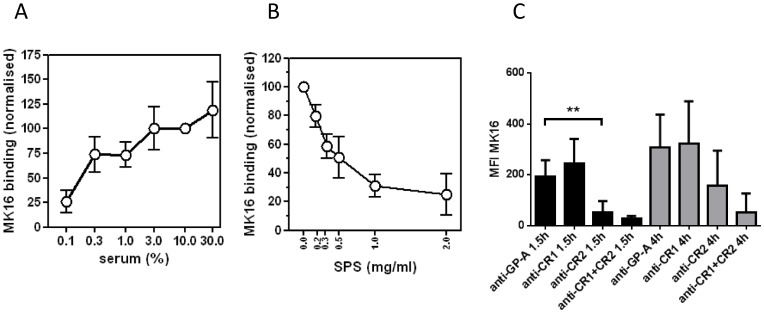
Influence of complement on the presentation of MBP85-99 by DR15+ B cells.PBMCs from healthy HLA-DR15+ donors were incubated for 18 h with MBP in media containing normal serum. Cells were stained with FITC anti-CD19 and biotinylated MK16, followed by streptavidin-PE. (A) The binding of MK16 at different serum concentrations is shown as mean fluorescence (MFI) values normalised to that of 10% serum, (N = 4). B) Before addition of serum (30% v/v), different concentrations of the complement inhibitory compound sodium polyanethole sulphonate (SPS) were added. MFI values are shown, normalised to samples without SPS, (N = 6). (C) The PBMCs were pre-incubated with the anti-CR1 mAb3D9 or polyclonal sheep anti-human CR2, or both, before addition of serum (30% v/v) and MBP. Anti-glycophorin (GP)-A was used as negative control. Data are shown as means±SEM, (N = 4–6). **p<0.01.